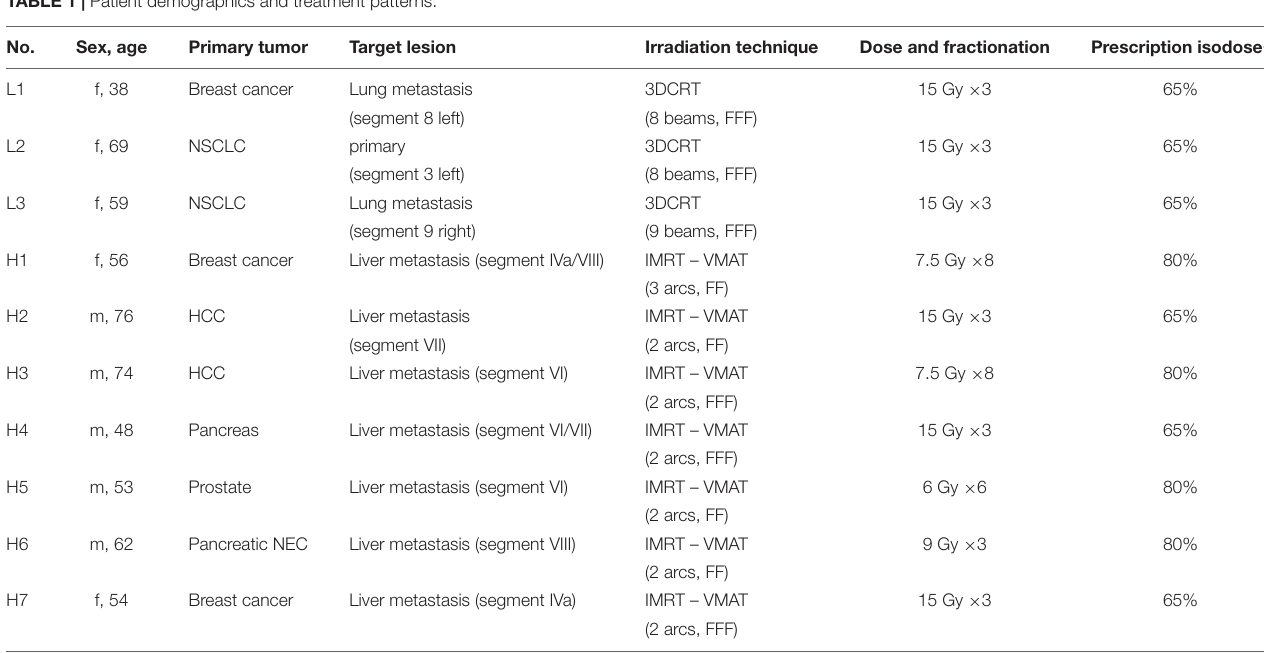
TABLE 1 | Patient demographics and treatment